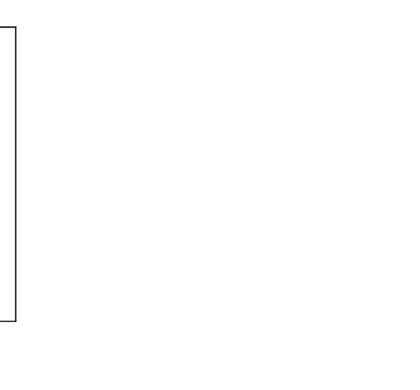
Figure 21. A scaled look at COVID-19 numbers over the past two years.